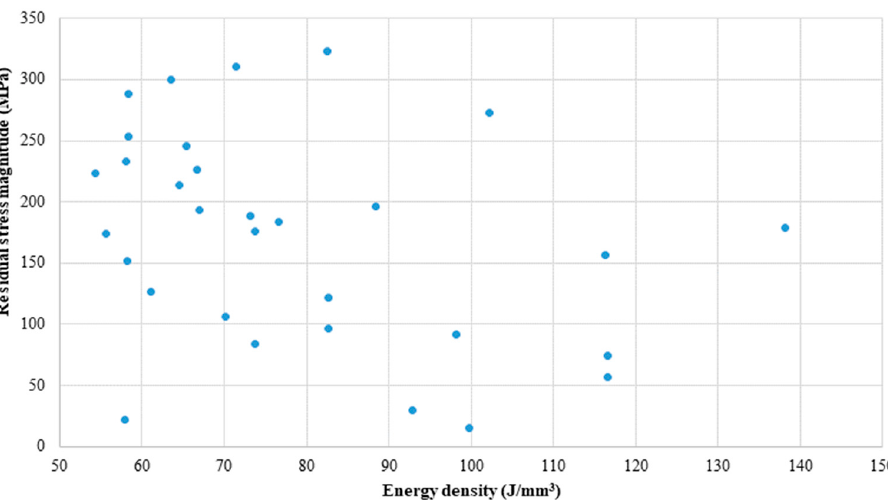
Figure 8. Scatter plots of the effect of energy density on residual stress magnitude (Adapted from [115] with permission in accordance with Creative Common CC BY license, open access).